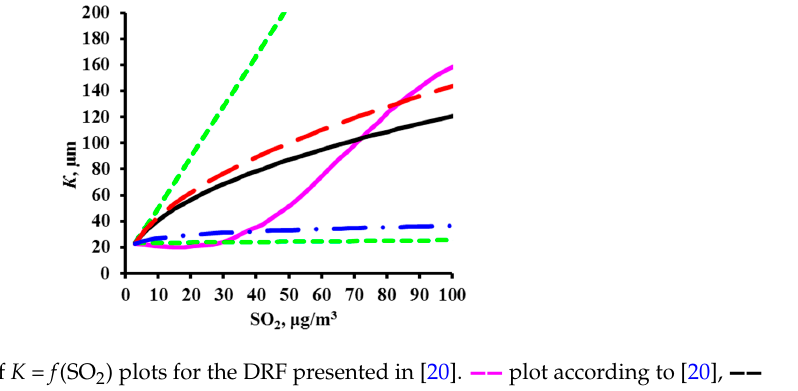
Figure 6. Comparison of K = f (SO 2 ) plots for the DRF presented in [20]. ▬▬ plot according to [20], ▬▬ by the New DRF; ▬ ▬ by the Standard DRF; ▬ • ▬ by the Unified DRF; - - - by the Linear DRF [20]. To perform a comparative estimate of k 1 and k 2 , let us use the value Т lim = 10 °C accepted in the